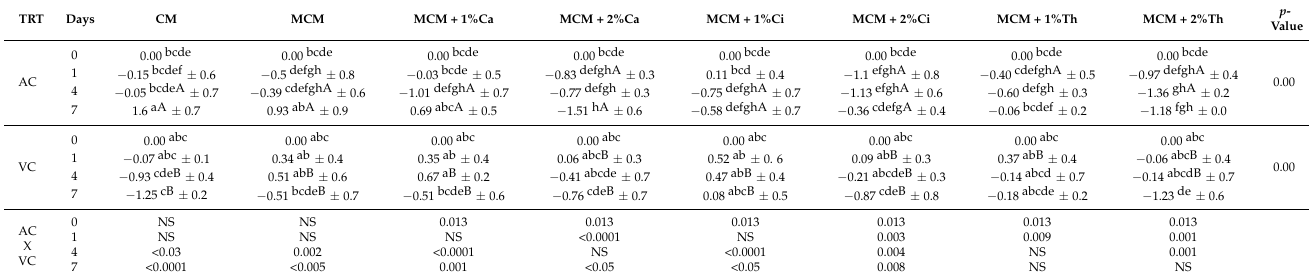
Table 5. Population changes of mesophilic lactic acid bacteria (log (N0/N) ± SD CFU/g) in marinated camel meat with essential oils under aerobic (AC) and vacuum (VC) conditions after storage at 4 ◦ C for 0, 1, 4 and 7